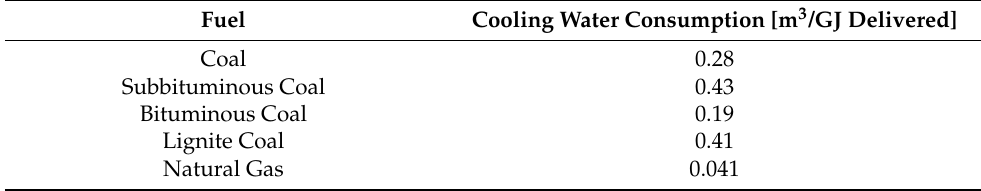
Table 5. Cooling water consumption depending on the fuel burnt (data source: